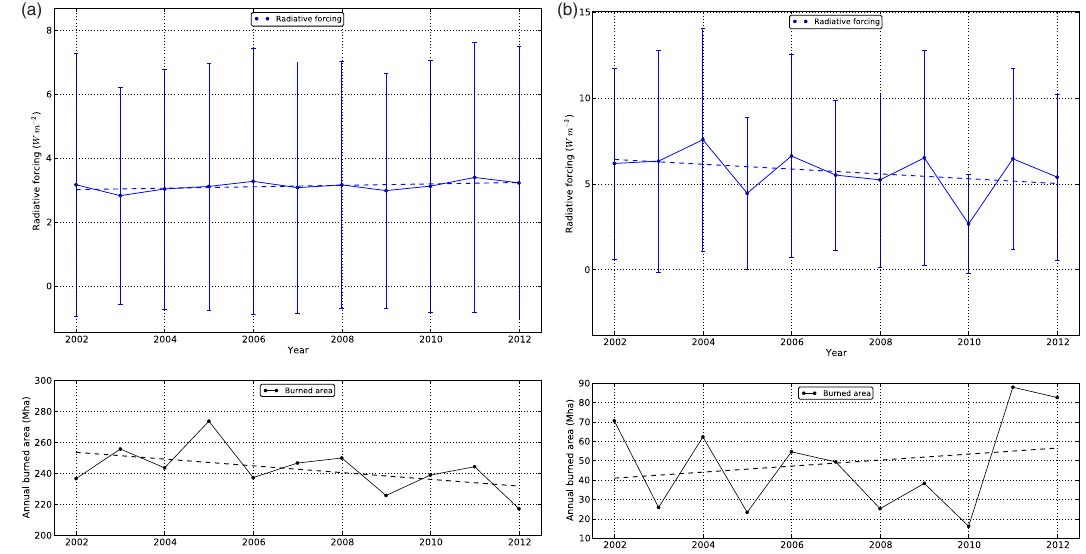
Figure 7. Temporal evolution of the radiative forcing and burned areas. Panel (a) shows the profiles for Africa, panel (b) for